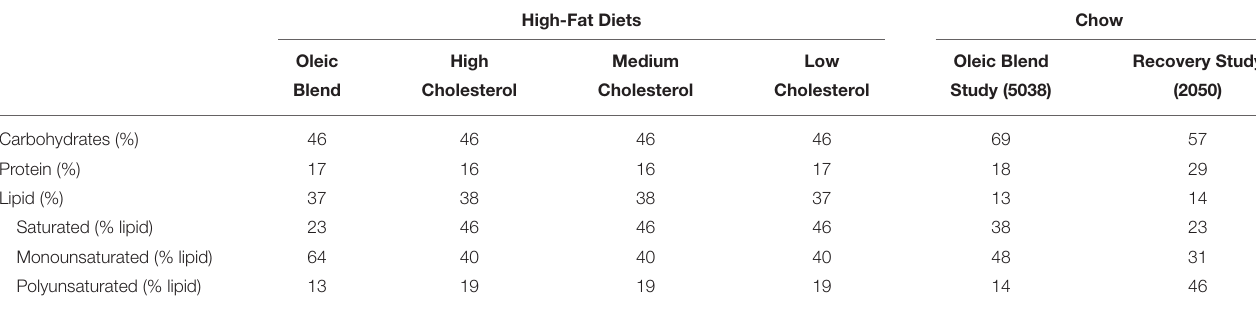
TABLE 1 | Macronutrient composition as percent total